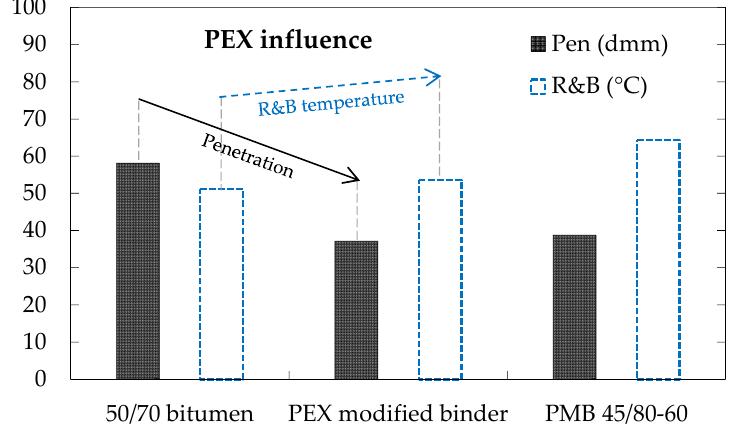
Figure 5. Differential scanning calorimetry (DSC) results of PEX waste.